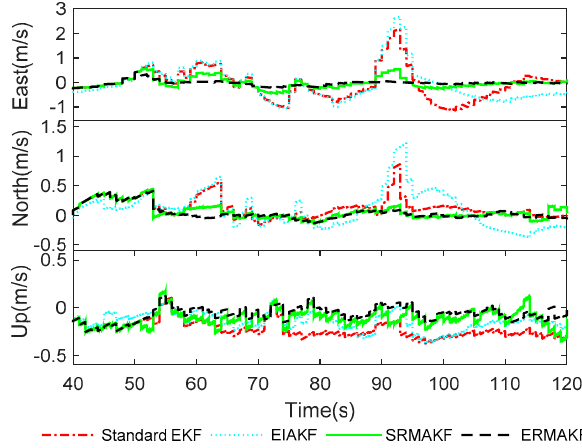
Figure 5. Velocity errors comparison.